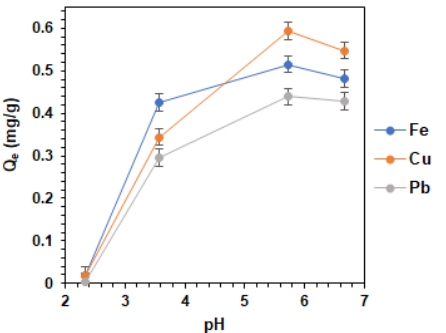
Figure 2. The effect of pH on the adsorption capacity of the MXM Copolymer.